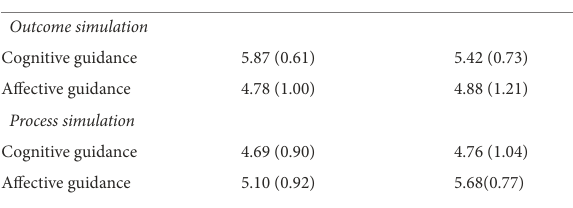
TABLE 3 Means and standard deviations of the four